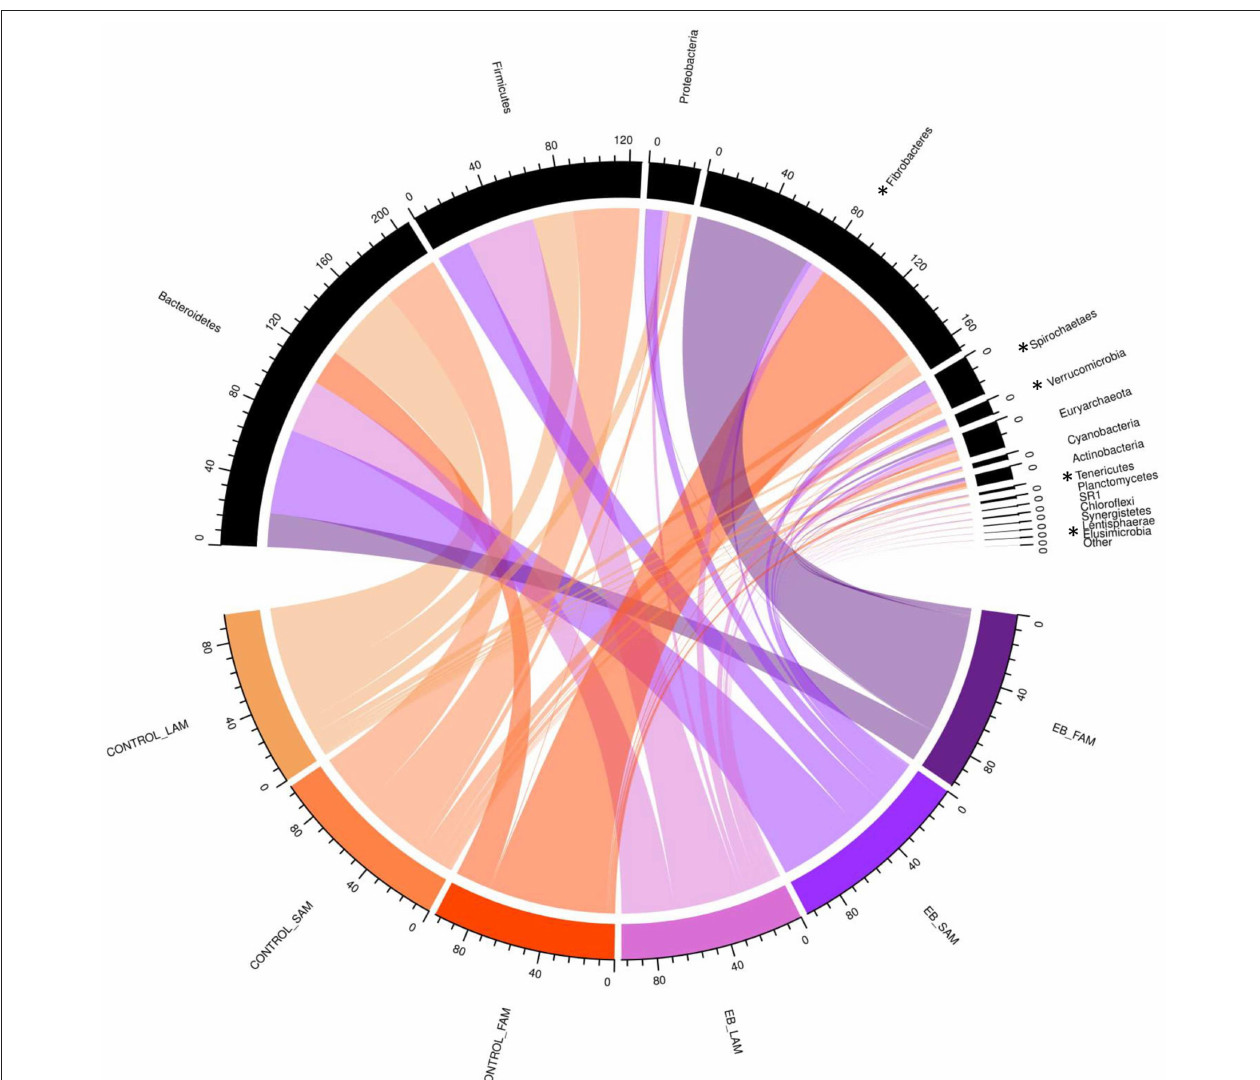
FIGURE 1 | Chord diagram displaying the relative abundance (%) of phylum associated with treatment (Control and 2.0% enhanced biochar) and source (SAM, solid associated microbes; LAM, liquid associated microbes; FAM, fecal associated microbes). The scale indicates total accumulative abundance. The width of each chord represents the relative abundance of each phylum that is associated with each treatment and source. Phylum with * indicate those with significant differences.